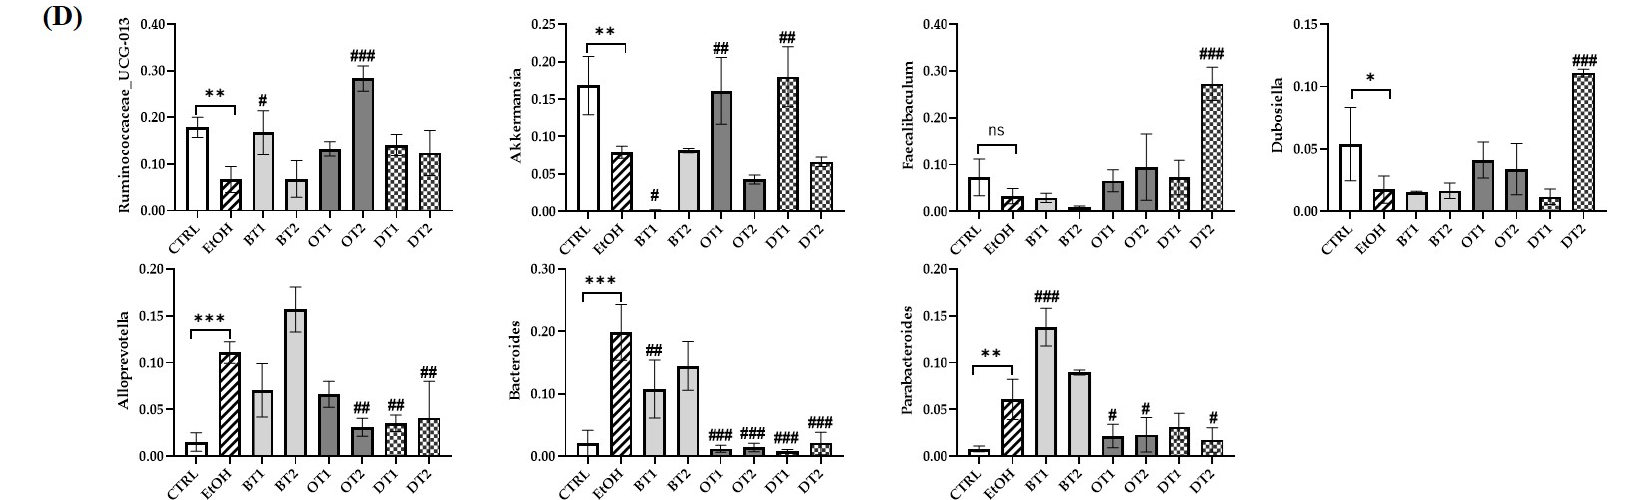
Figure 8. The effects of teas on the composition of microbiota in mice affected by chronic alcohol exposure. CTRL, the control group; EtOH, the model group; BT1, Dianhong Tea; BT2, Yingde Black Tea; OT1, Tieguanyin Tea; OT2, Fenghuang Danzong Tea; DT1, Fu Brick Tea; DT2, Selenium-Enriched Dark Tea. ( A ) Relative abundance of the faecal microbial profile of each group at the phylum level. ( B ) Relative abundance of the faecal microbial profile of each group at the genus level. ( C ) Relative abundance of Firmicutes, Bacteroidetes, the ratio of Firmicutes/Bacteroidetes, Verrucomicrobia, Proteobacteria, Epsilonbacteraeota, and Actinobacteria. ( D ) Relative abundance of Ruminococcaceae_UCG-013, Akkermansia, Faecalibaculum, Alloprevotella, Bacteroides, Parabacteroides, and Dubosiella. * p < 0.05, ** p < 0.01, *** p < 0.001, the model group compared with the control group; # p < 0.05, ## p < 0.01, ### p < 0.001, the tea extract supplementary groups compared with the model group.